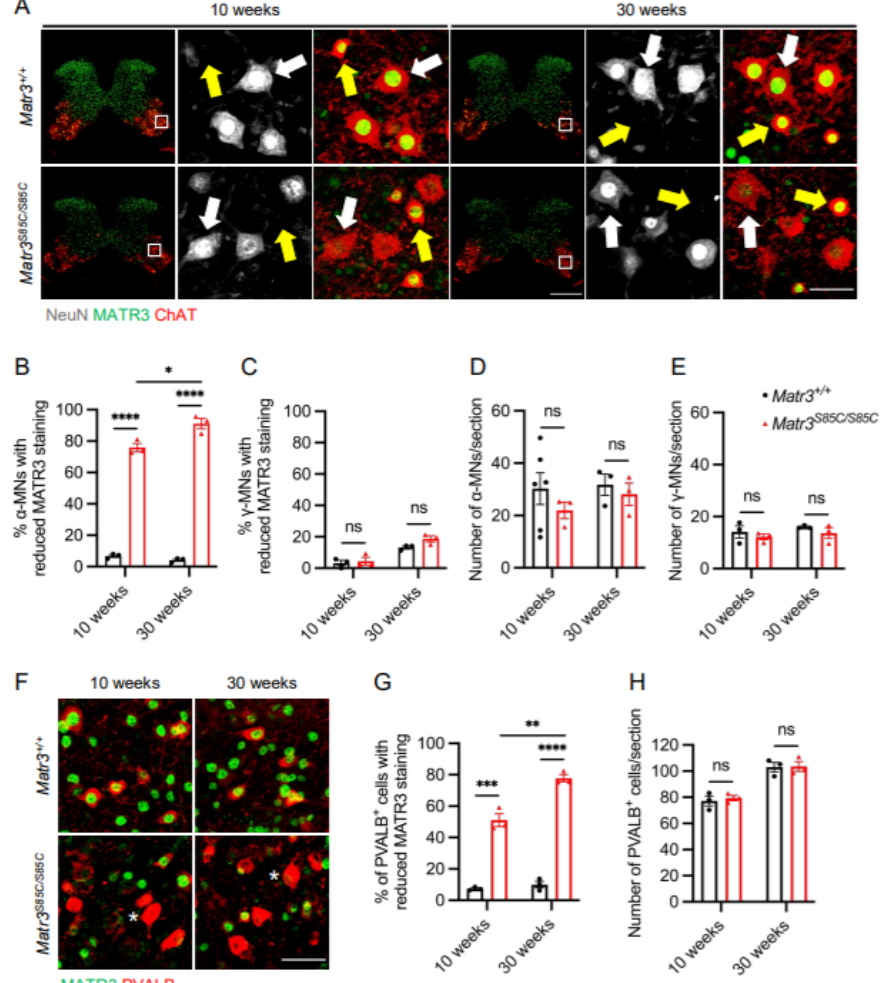
Figure 1. MATR3 loss in α -motor neurons and interneurons in the cervical spinal cord of Matr3 S85C/S85C mice. ( A ) Representative images of 10 and 30 weeks cervical spinal cord staining for α -motor neurons (ChAT + , NeuN + , denoted by white arrows) and γ -motor neurons (ChAT + , NeuN − , denoted by yellow arrows). Scale bar for the spinal cord image denotes 500 µ m and the zoomed-in image denotes 50 µ m. Quantification of the percentage of motor neurons with reduced MATR3 staining in ( B ) α -motor neurons (10 weeks: n = 3 Matr3 +/+ , 3 Matr3 S85C/S85C ; 30 weeks: n = 3 Matr3 +/+ , 3 Matr3 S85C/S85C ) and ( C ) γ -motor neurons (10 weeks: n = 3 Matr3 +/+ , 3 Matr3 S85C/S85C ; 30 weeks: n = 3 Matr3 +/+ , 3 Matr3 S85C/S85C ). Quantification of the number of ( D ) α -motor neurons (10 weeks: n = 6 Matr3 +/+ , 3 Matr3 S85C/S85C ; 30 weeks: n = 3 Matr3 +/+ , 3 Matr3 S85C/S85C ) and ( E ) γ -motor neurons (10 weeks: n = 3 Matr3 +/+ , 3 Matr3 S85C/S85C ; 30 weeks: n = 3 Matr3 +/+ , 3 Matr3 S85C/S85C ). ( F ) Representative images of 10 and 30 weeks PVALB + interneurons in the cervical spinal cord. Interneurons with reduced MATR3 staining are denoted by a white asterisk. Scale bar denotes 50 µm. ( G ) Quantification of the percentage of PVALB + interneurons with reduced MATR3 staining (10 weeks: n = 3 Matr3 +/+ , 3 Matr3 S85C/S85C ; 30 weeks: n = 3 Matr3 +/+ , 3 Matr3 S85C/S85C ). ( H ) Quantification of the number of PVALB + interneurons (10 weeks: n = 3 Matr3 +/+ , 3 Matr3 S85C/S85C ; 30 weeks: n = 3 Matr3 +/+ , 3 Matr3 S85C/S85C ). Bar graph heights depict mean ± SEM, with each datapoint representing an animal. * p < 0.05, ** p < 0.01, *** p < 0.001, **** p < 0.0001, ns = not significant.